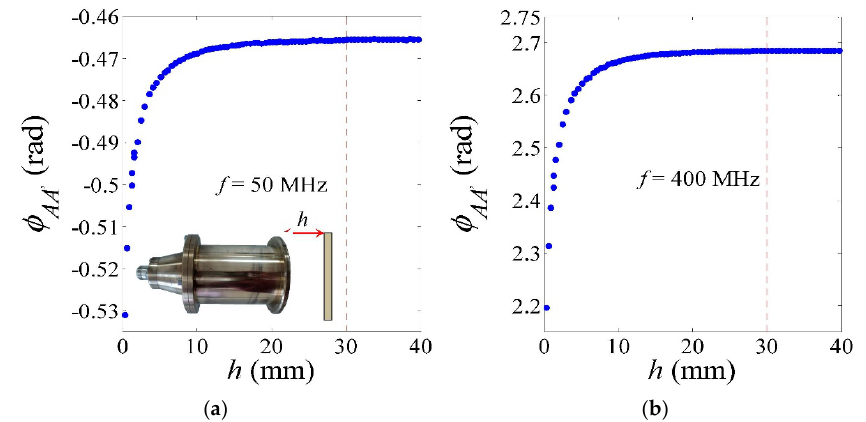
Figure 2. Experimental set-up and measurement.